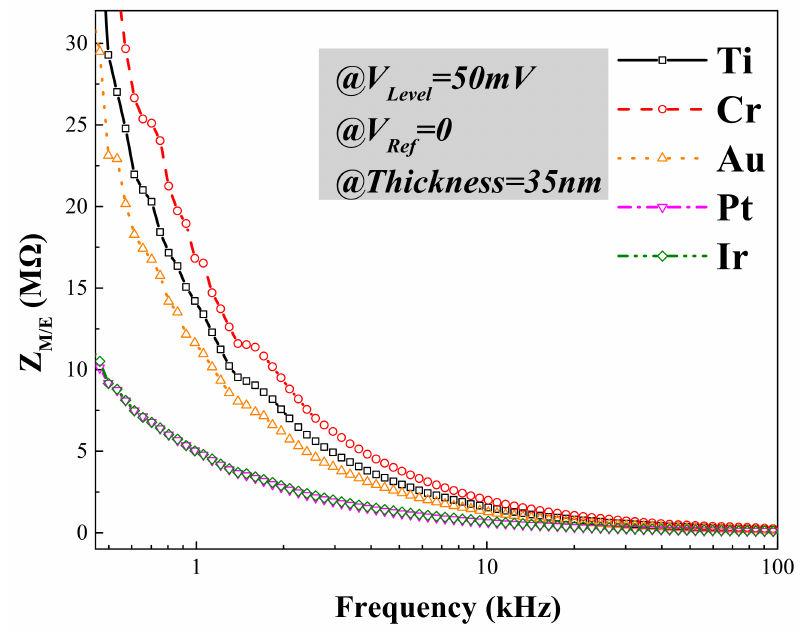
Figure 4. Electrochemical impedance spectroscopy (EIS) of microelectrodes with different surface materials, including Ti, Cr, Au, Pt and